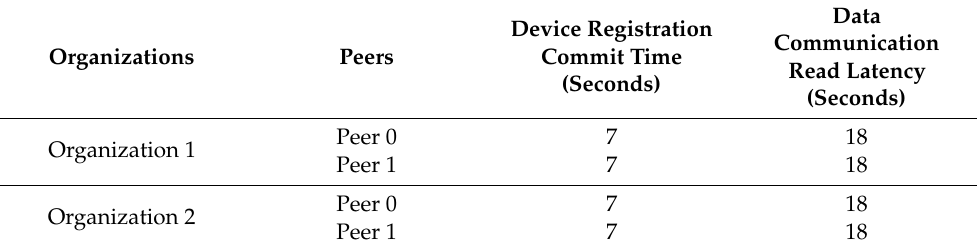
Table 6. Hyperledger Fabric Transaction